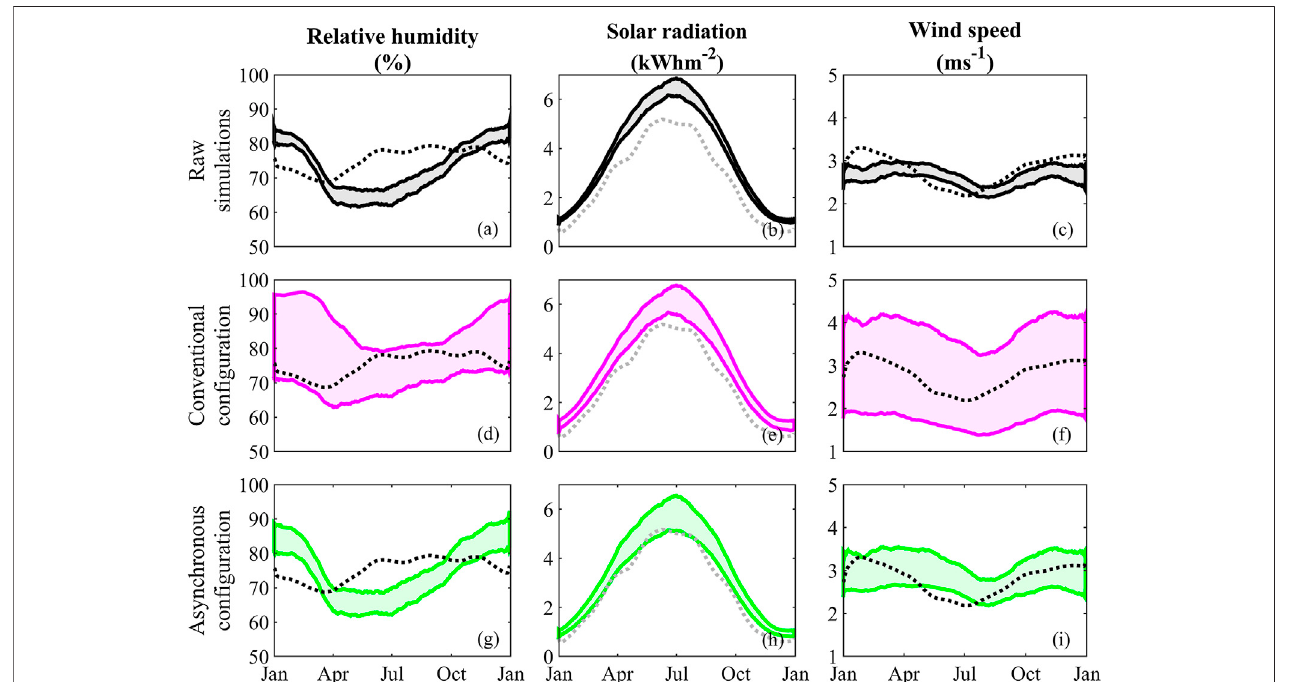
FIGURE 4 | Daily mean annual cycles for relative humidity, solar radiation, and wind speed issued by CRMC5-LE over Du Loup catchment between 1980 and 2009. First row presents raw simulations (black, spread given by three CRCM5-LE members). Second and third rows present post-processed variables issued by conventional (magenta, three members and four reanalysis) and asynchronous (green, three members and 16 optimization realizations) con fi gurations of the hydroclimaticmodelingchain.Observationsfromneighboringmeteorologicalstations(dashedblack)andfrom For ˆ etMontmorency experimentalsite(dashedgray, 120 km) are given as